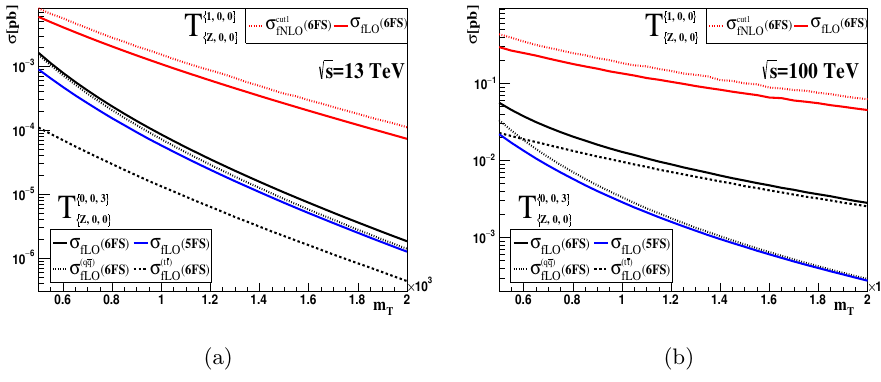
p at s = 13 TeV and 100 TeV T